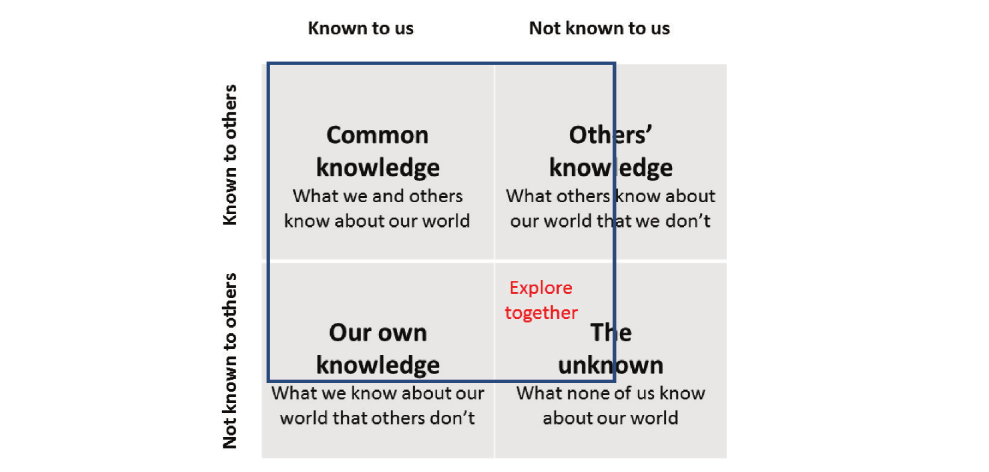
Figure 4: Generating new knowledge with others